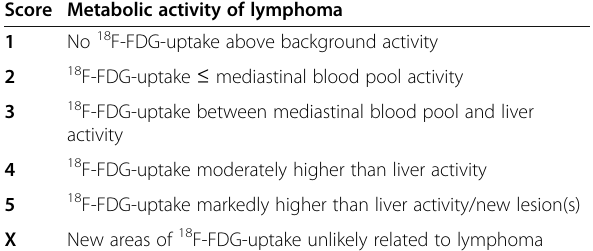
Table 3 Five-point Deauville score system Score Metabolic activity of